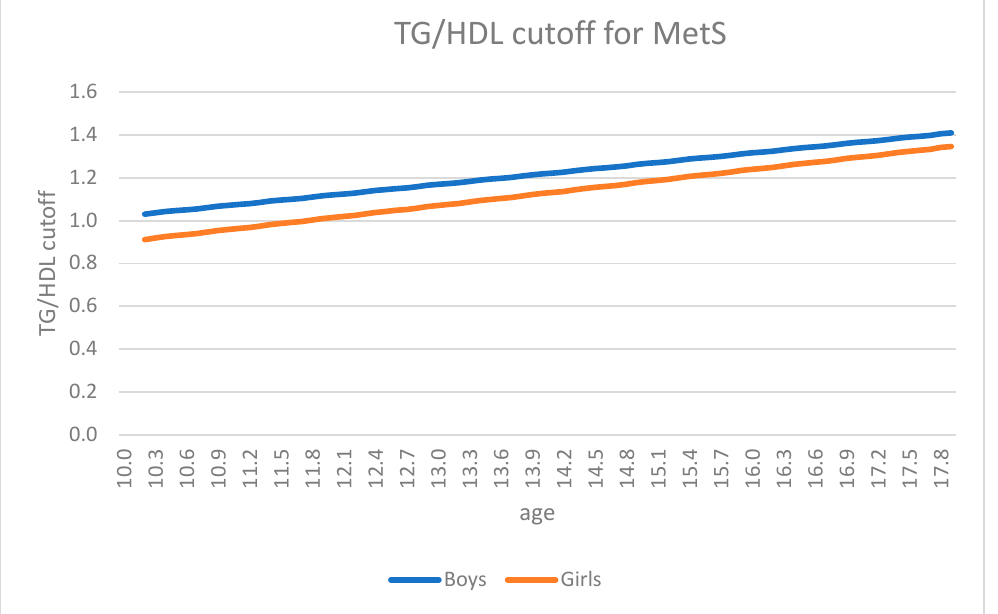
Figure 3. Trend of TG/HDL cutoff for MetS, according to age and sex. The mean difference of the cut-off values calculated at all ages between sexes ( p < 0.05). Abbreviation: TG/HDL: triglyceride to high density-lipoprotein cholesterol ratio.